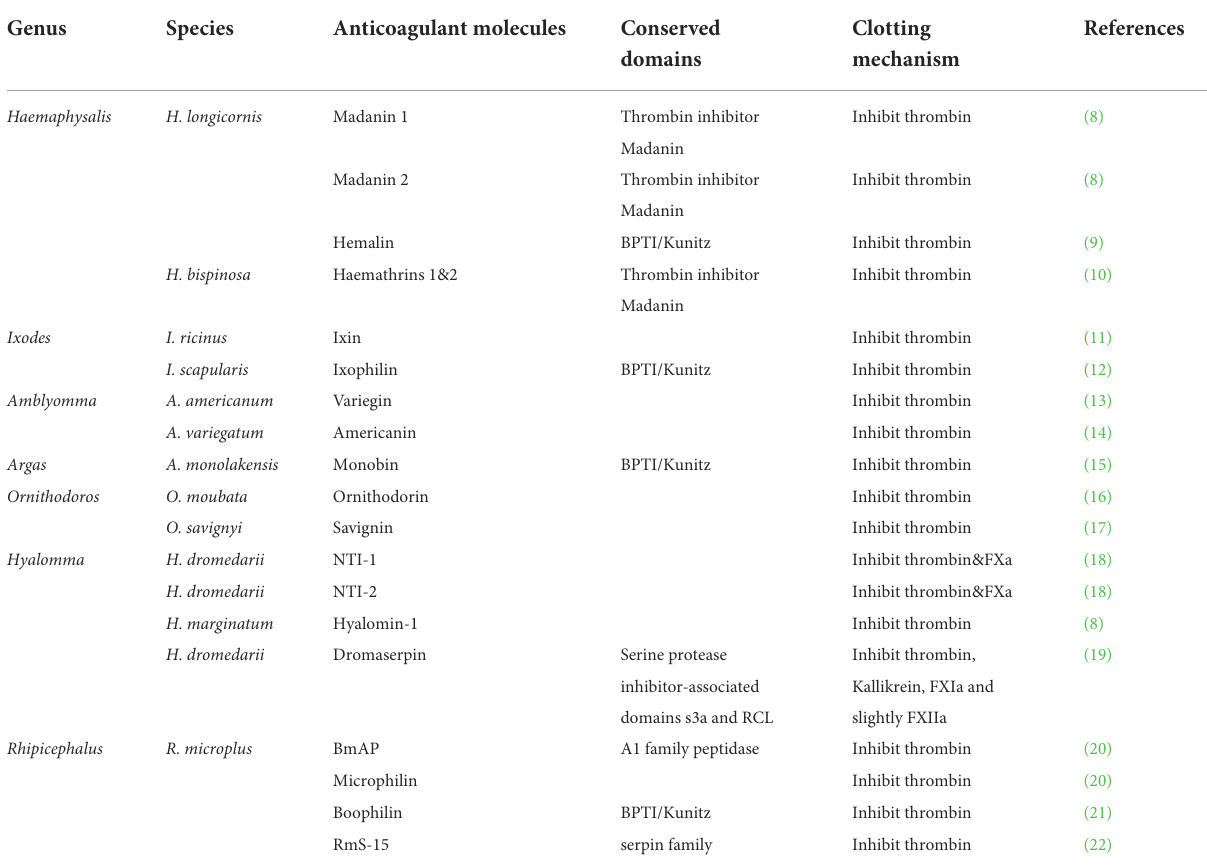
TABLE 1 Thrombin inhibitors in ticks.